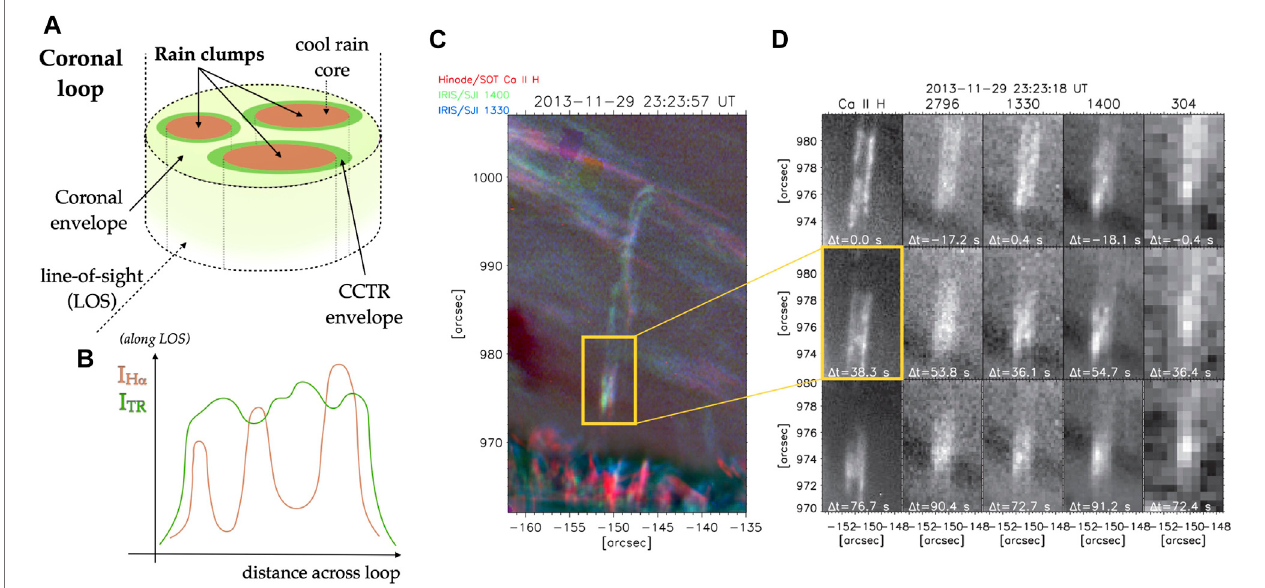
FIGURE 9 | Morphology of a rain clump and a shower. (A) Sketch of a 3D cross-section of a coronal loop with coronal rain. The cool cores are surrounded by the CCTR(condensationcoronatransitionregion),athinenvelopeofwarmermaterialattransitionregiontemperatures,whichisitselfsurroundedbycoronalplasma. (B) the emerging intensity in chromospheric (orange, e.g., H α ) and transition region (TR) lines when observing the loop along the sideways LOS, as indicated on the left. The sketches are taken from Antolin (2020) ( Figure 2 ). (C) A shower event observed with Hinode /SOT in Ca II H (in red, T ≈ 10 4 K), IRIS /SJI 1330 (in blue, T ≈ 10 4.3 K) and IRIS /SJI 1400 (in green, T ≈ 10 4.8 K). (D) Zooming onto the head of the shower, various clumps and a strand-like structure (aligned with the fl ow of the rain) can be seen. From (A – D) , the panels are placed in order of increasing temperature formation (with IRIS /SJI 2796 at T ≈ 10 4 K and AIA/304 at T ≈ 10 5 K), and from (A, B) at 3 consecutive instances in time (the snapshotsclosest in time toSOT are chosen for each instrument). For more details seeAntolin et al. (2015) (adapted from Figures 10, 11 of that paper, © AAS. Reproduced with